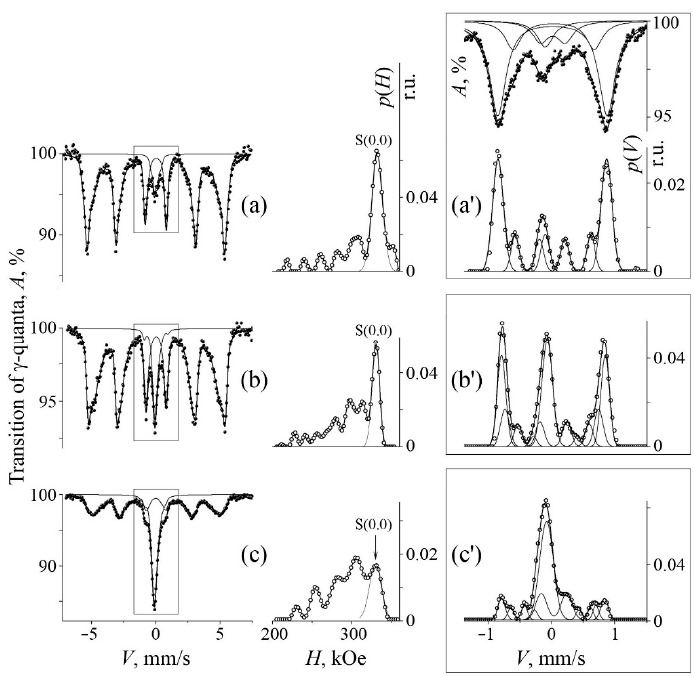
Figure 2. Mössbauer data of the MA samples after BM of Series A : ( a – c ) the Mössbauer spectra and distributions of the p ( H ) of the sextet for the α phase; ( a’ ) the Mössbauer spectra and distribution of the p ( V ) of the center of the spectrum; ( b’ , c’ ) distributions of the p ( V ) of the center of the spectra. Treatment, composition: ( a , a’ ) BM, composition 1 (Fe + 20% CrN); ( b , b’ ) BM, composition 3 (Fe– 6.7Mn + 20% CrN); ( c , c’ ) BM, annealing at 800 °C, 1 h, composition 4 (Fe–8.9Mn + 20%